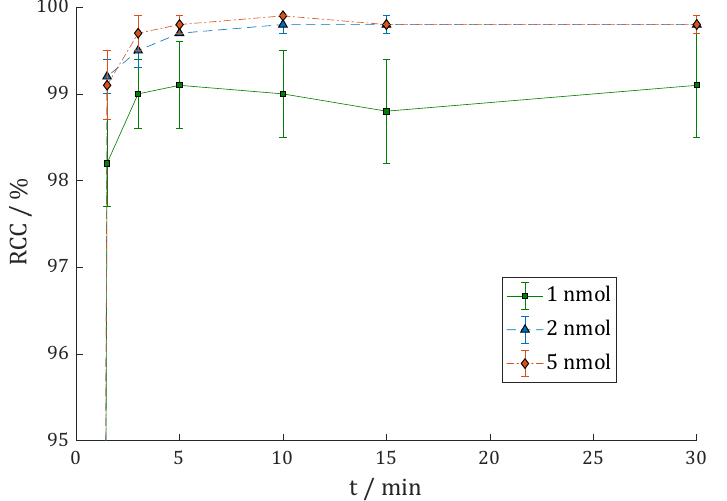
Figure 4. Reaction kinetics (radiochemical conversion (RCC) in %) of [ 177 Lu]Lu-DOTAGA.Glu.(FAPi) 2 177 Lu ‐ 7 in 1 M HEPES (pH = 5.5) at 95 °C with 50–100 MBq 177 Lu (n = 3).